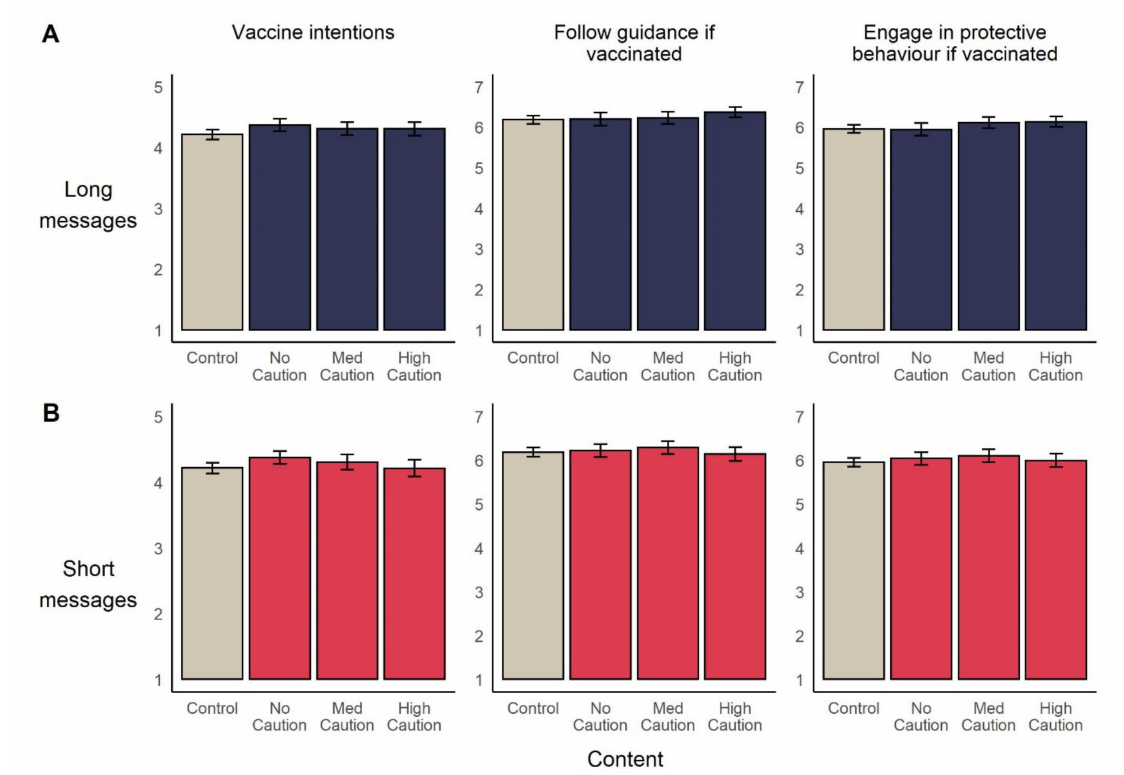
Figure 4. Mean (95%CI) levels of vaccine and behavioural intentions, across experimental conditions. In line with ANOVAs reported in main text, Long messages ( A ) and Short messages ( B ) are separately compared to